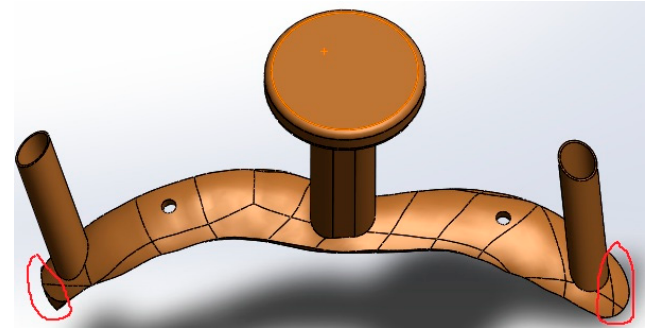
Figure 12. Redundant parts of the atlas template (marked in red).